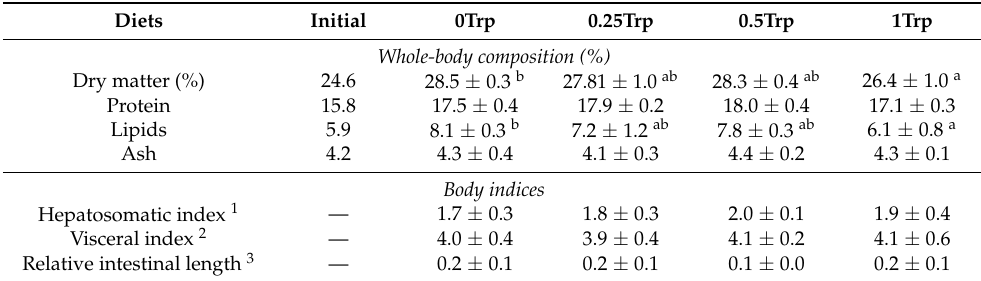
Table 4. Whole-body composition, hepatosomatic index and visceral index of meagre fed the experi- mental